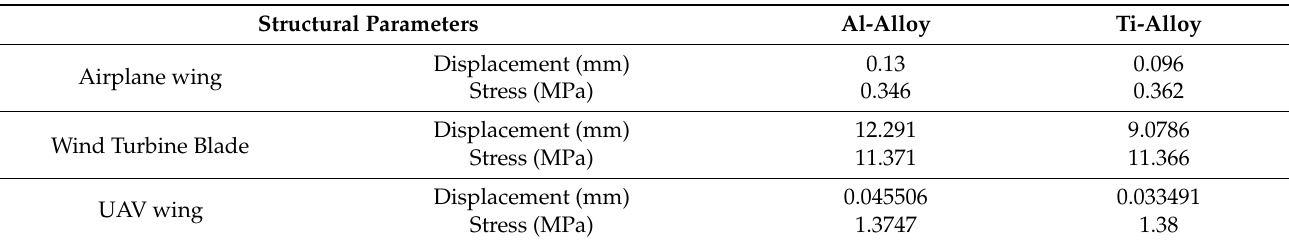
Table 5. Comparative FSI results of aerospace